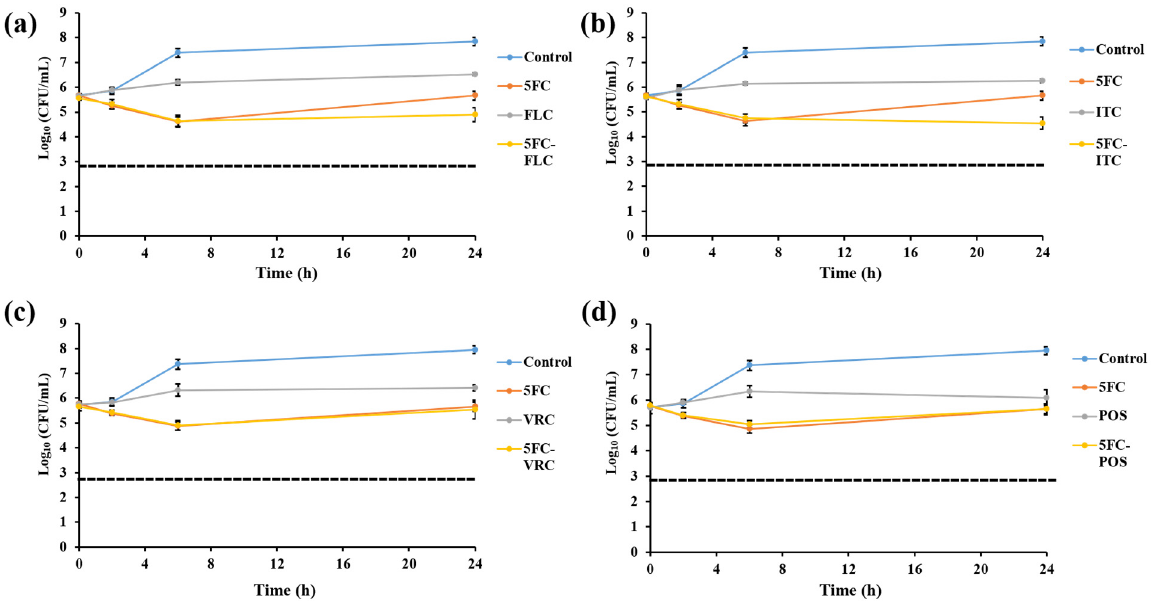
Figure 5. In vitro activities of 5FC alone (0.1 µ g/mL) and in combination with FLC 25 µ g/mL; ( a ), ITC 4 µ g/mL; ( b ), VRC 1 µ g/mL; ( c ), and POS 4 µ g/mL; ( d ) against C. glabrata IFM60089 as determined by the time-killing assay. The detection limit was 20 CFU/mL. Dashed lines represent a >99.9% growth reduction compared with the initial inoculum size for determination of fungicidal activity. All 5FC combinations with azoles showed indifferent interactions. Each data point represents the means ± standard deviation of results from two independent experiments.